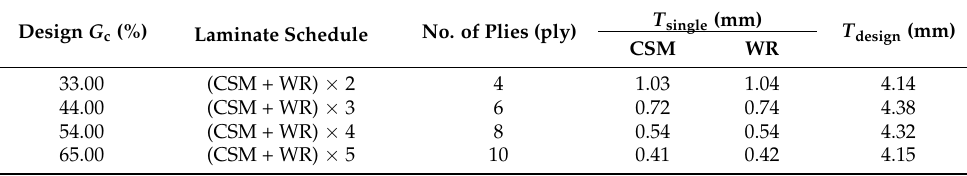
Figure 4. Designs of combined-material specimens produced using chopped strand mat and wo- ven roving. Table 2. Design details of combined-material specimens. Table 2. Design details of combined-material